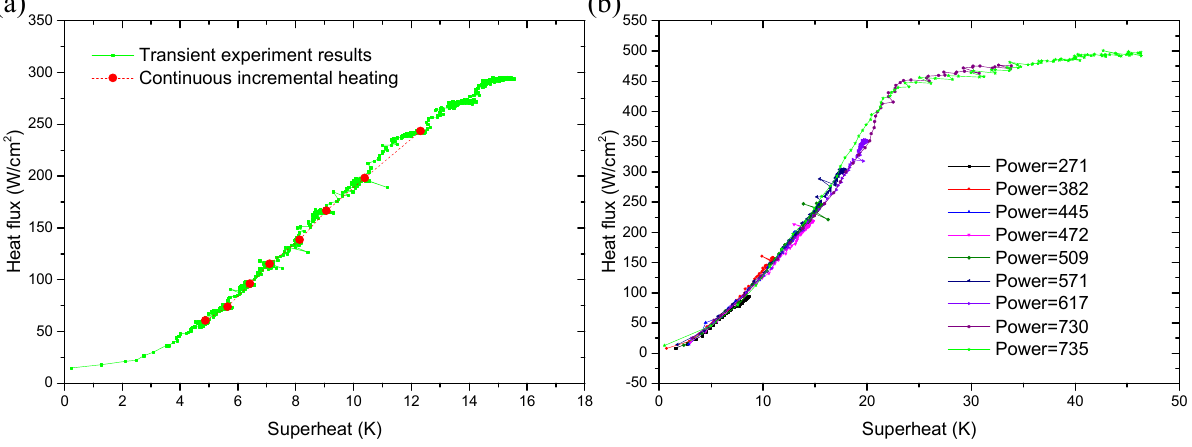
Figure 9. Superheat dependence of heat flux under different heating conditions: ( a ) Continuous incremental heating; ( b ) intermittent heating.